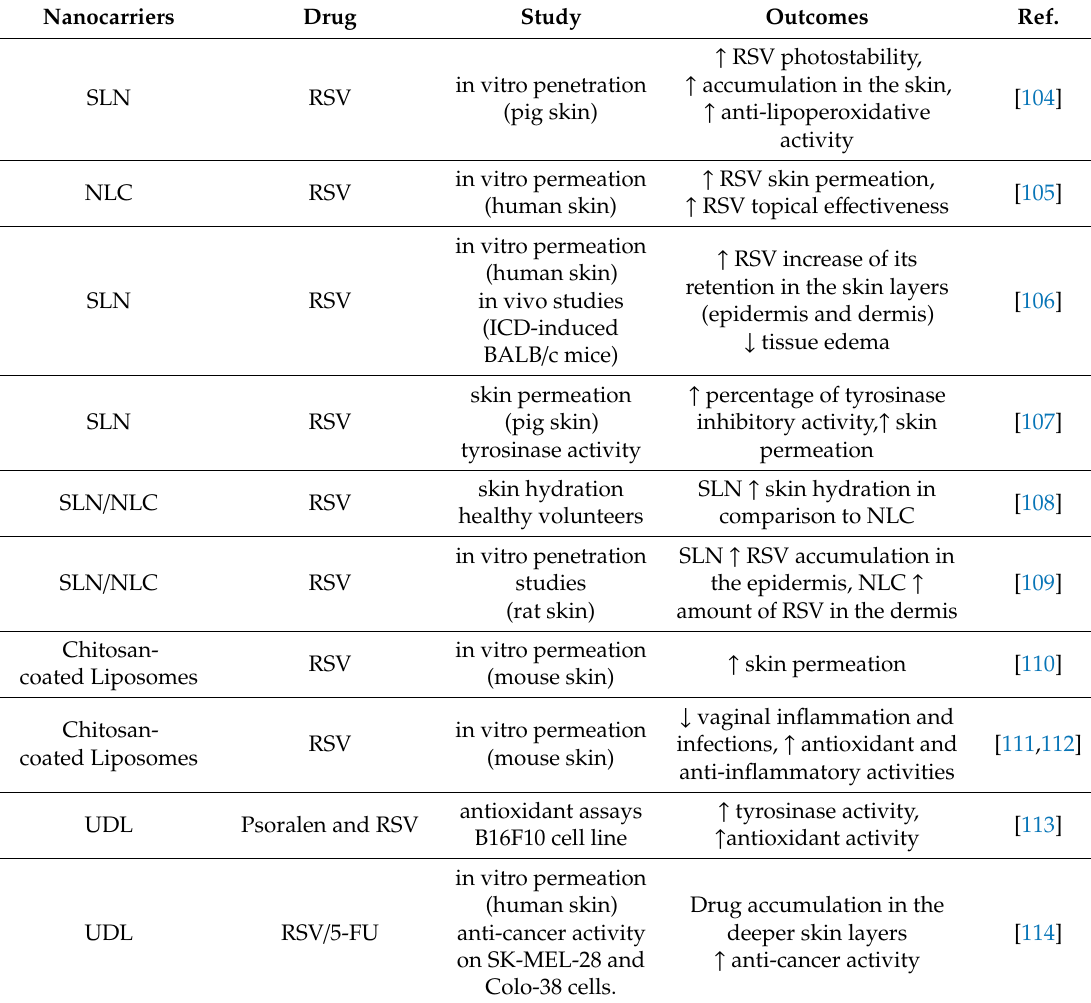
Table 4. Topical resveratrol (RSV) drug delivery systems. SLN = solid lipid nanoparticles; NLC = nanostructured lipid carriers; UDL = ultra-deformable liposomes; 5-FU =